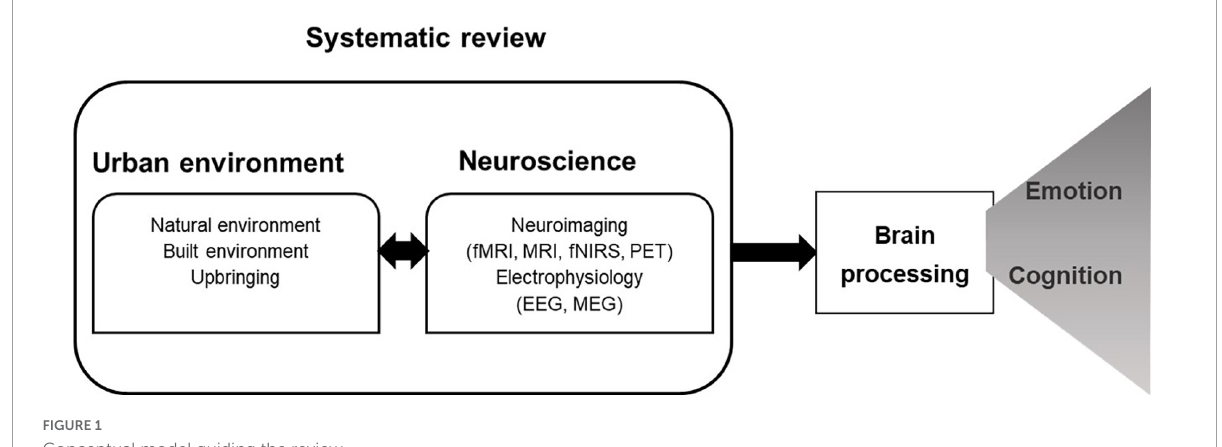
FIGURE1 Conceptual model guiding the